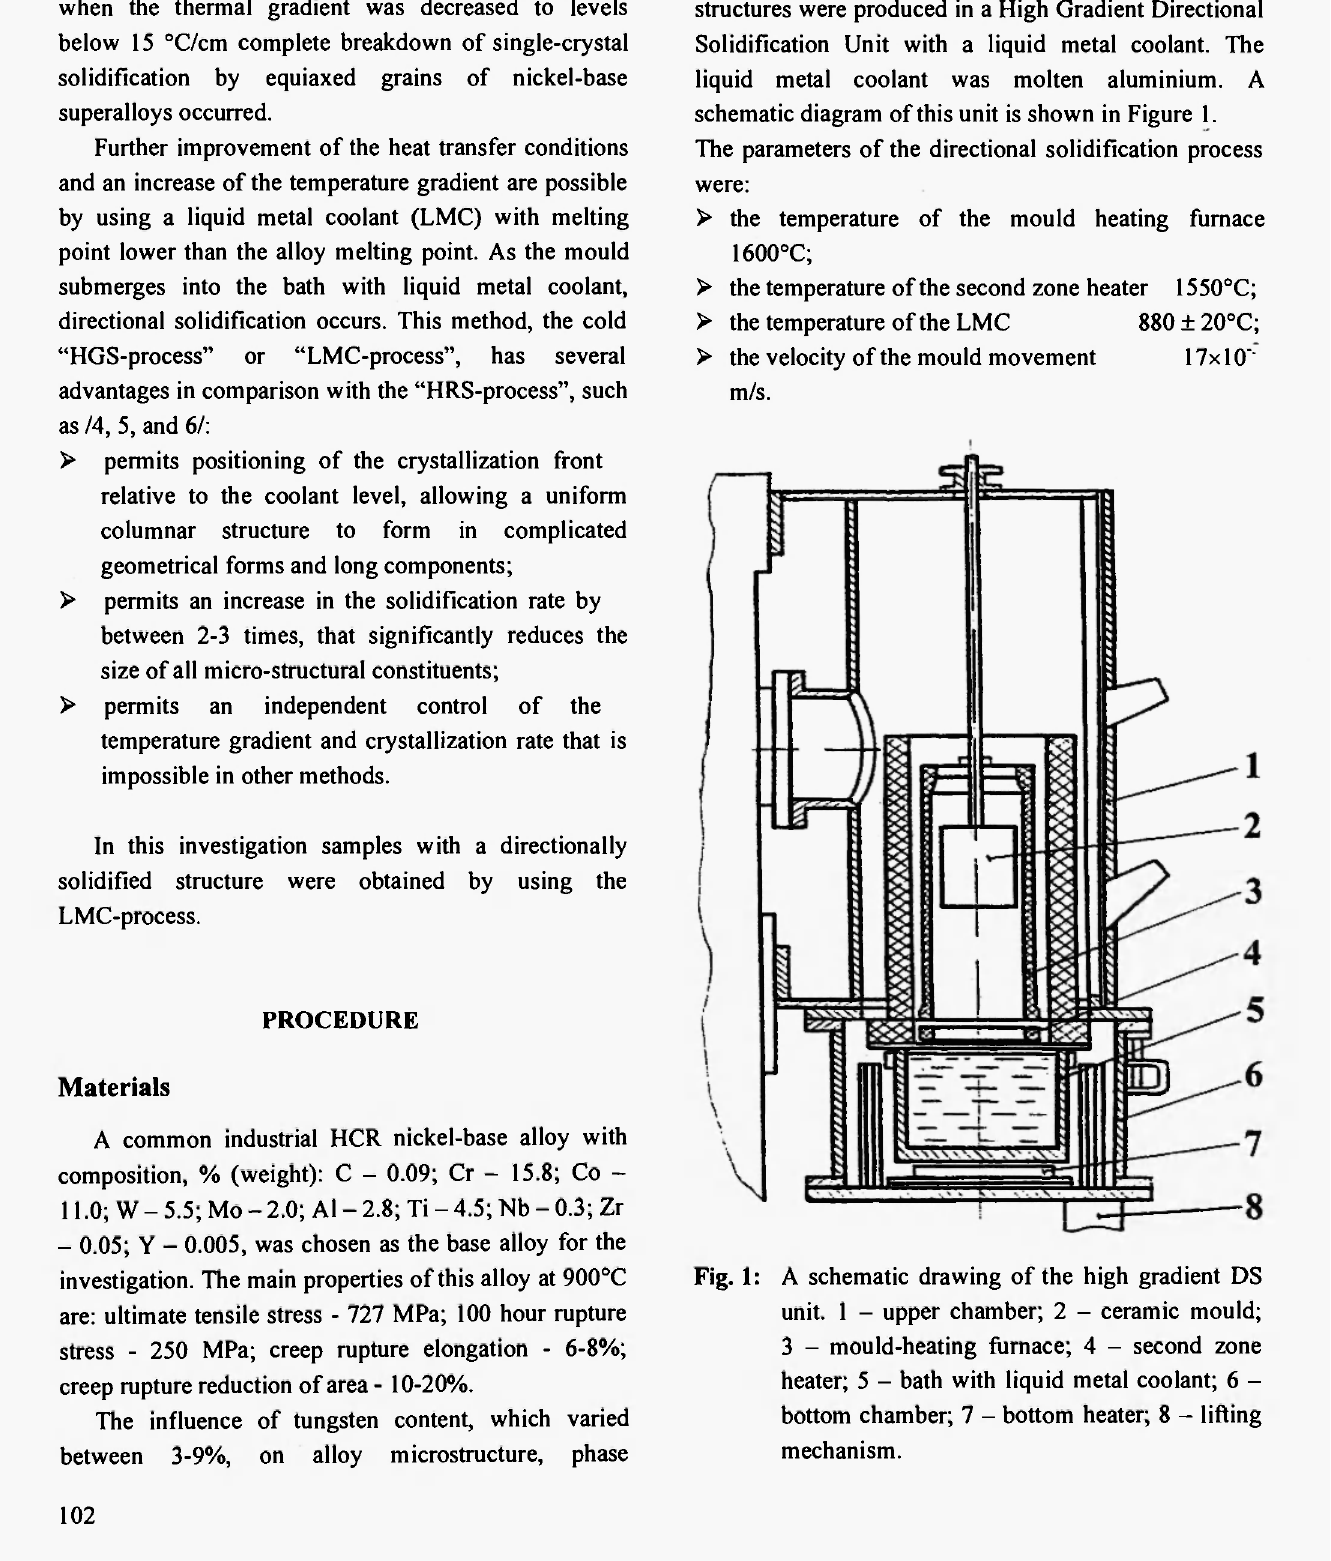
Fig. 1: A schematic drawing of the high gradient DS unit. 1 - upper chamber; 2 - ceramic mould; 3 - mould-heating furnace; 4 - second zone heater; 5 - bath with liquid metal coolant; 6 - bottom chamber; 7 - bottom heater; 8 - lifting